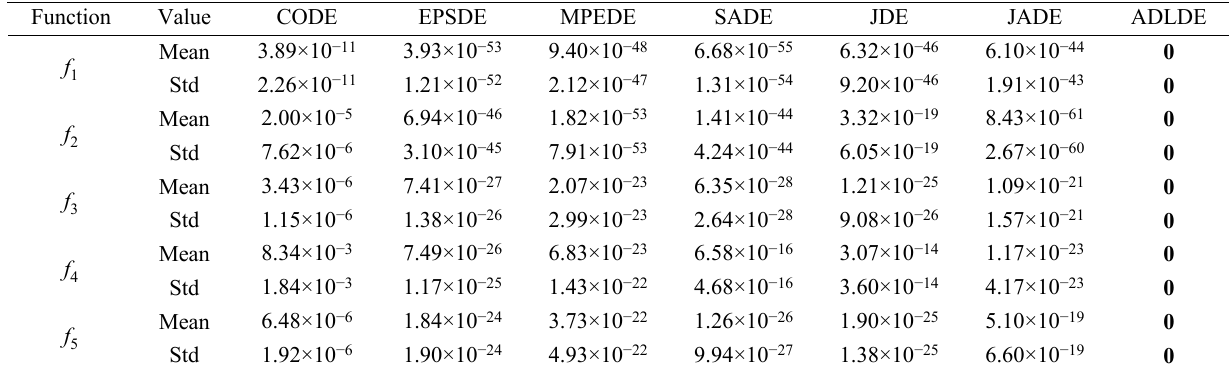
Table A2 Function error values of benchmark functions when D =